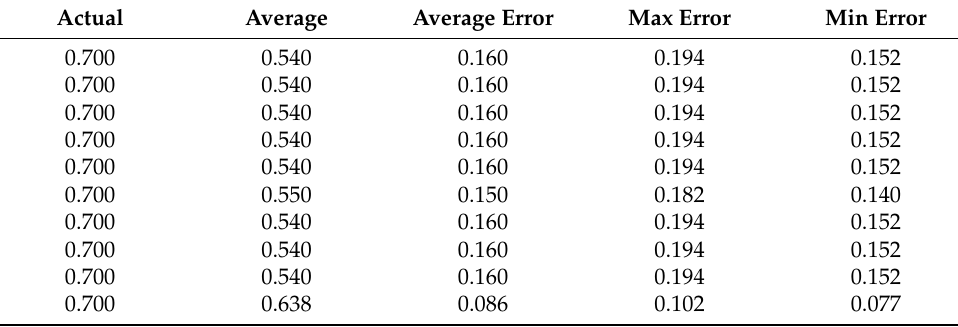
Table A49. Set 1, trials 31–40 data (all 0.5 PR